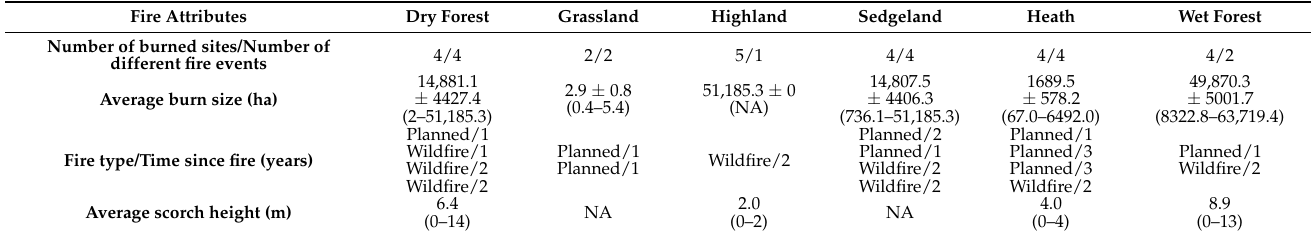
Table 1. Fire attributes in the selected vegetation community types.